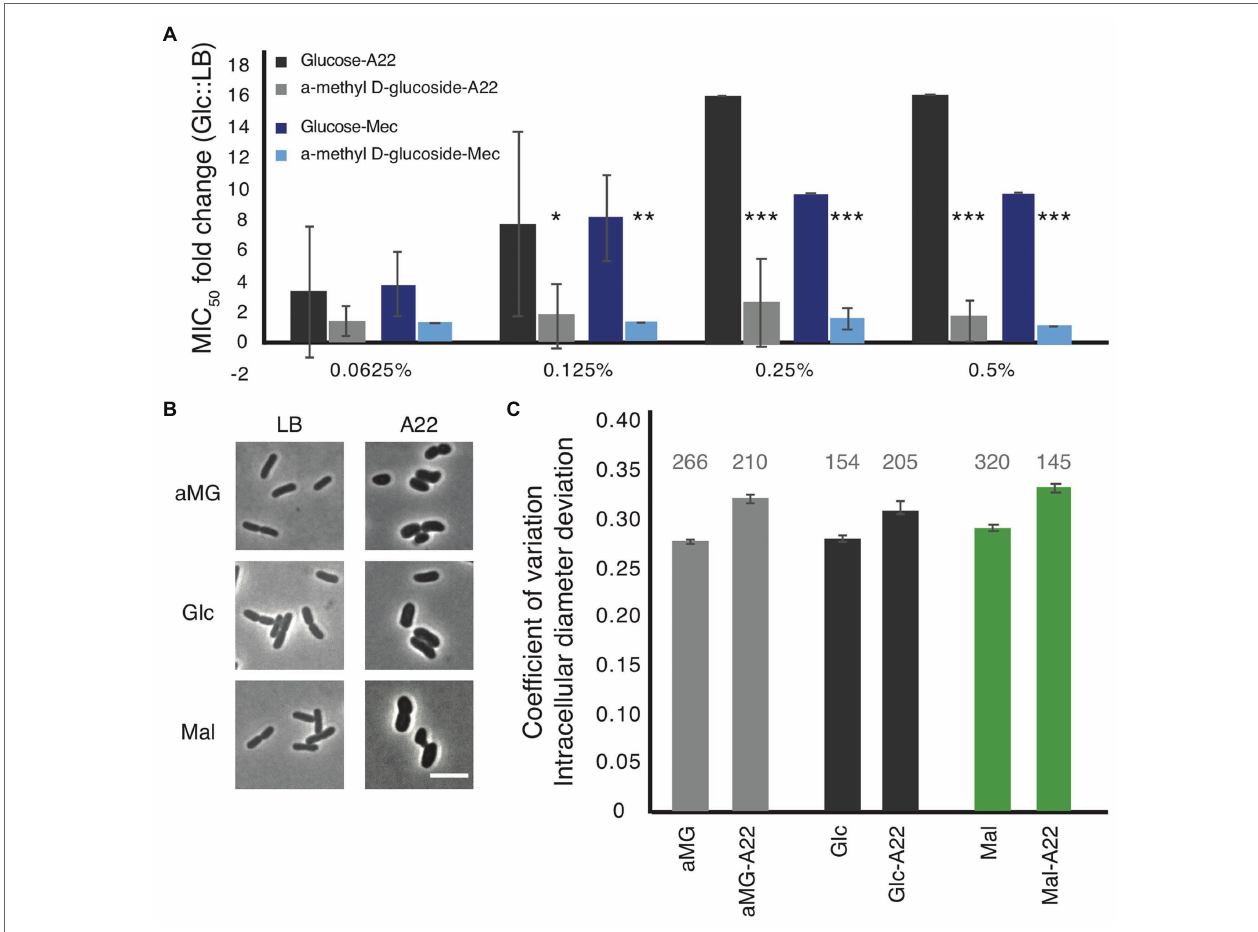
FIGURE 4 | The addition of glucose to the medium phenocopies, the antibiotic tolerant phenotypes of the mdh deletion. (A) WT cells were grown in LB medium supplemented with the indicated amount of either glucose or a non-hydrolizable glucose mimic, α -methyl D-glucoside ( α MG). Cells were treated with either A22 (black bars) or mecillinam (blue bars). Error shown is SD from three independent experiments. * p < 0.05, *** p < 0.001 comparing glucose to α MG for each condition. (B,C) Cells were grown with 0.2% α MG, glucose (glc), or malate (mal) for 4 h before imaging (LB) or for 2 h before a spike of 10 μ g/ml, A22 for another 2 h. (B) Images of cells. (C) Quantification of how rod-like cells are. Coefficient of variation of the intracellular diameter deviation (IDD) measures rodness. The higher the number the less rod-like cells appear. A22 causes cells to round up in all conditions but the effect is less when cells are grown in glucose. Number above each bar represents the total number of cells